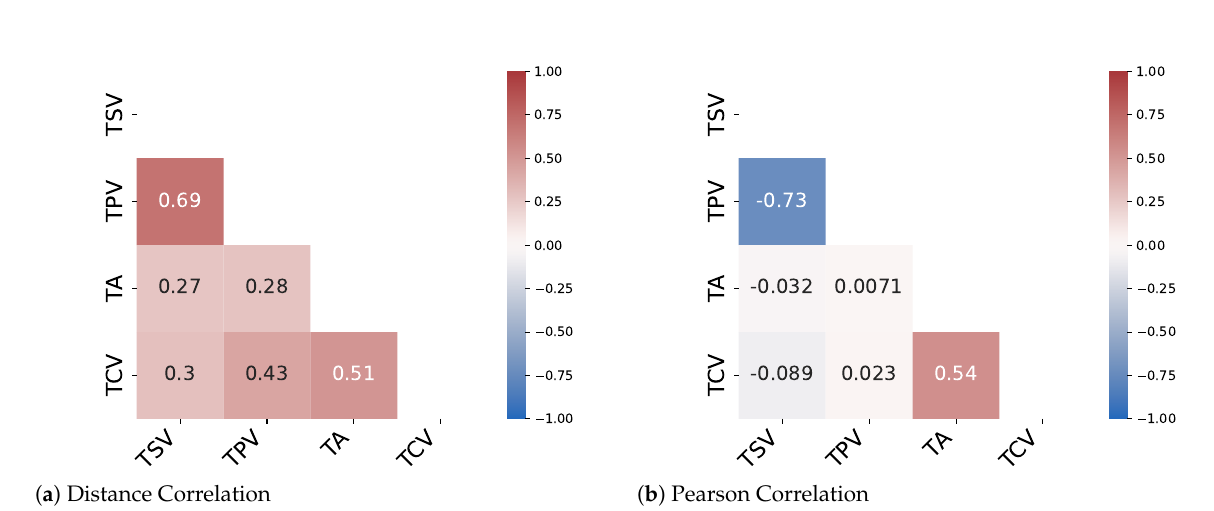
Figure 5. Correlation Analysis of TC metrics for adults in ASHRAEII Database.